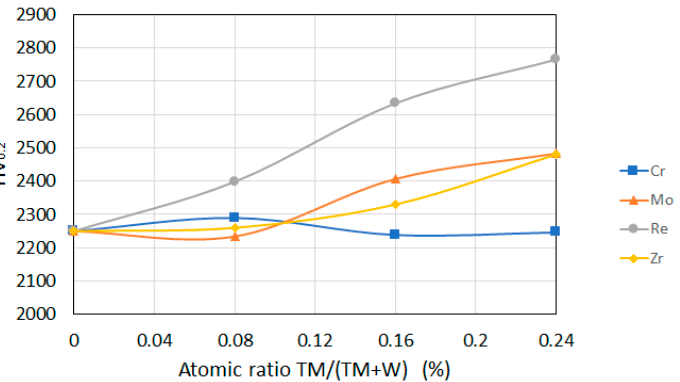
Figure 5. Hardness of W x TM x − 1 B 2.5 , (0 < x ≤ 0.24 TM = Cr, Mo, Re, Zr); specimens spark plasma sintered at holding times 24 min.